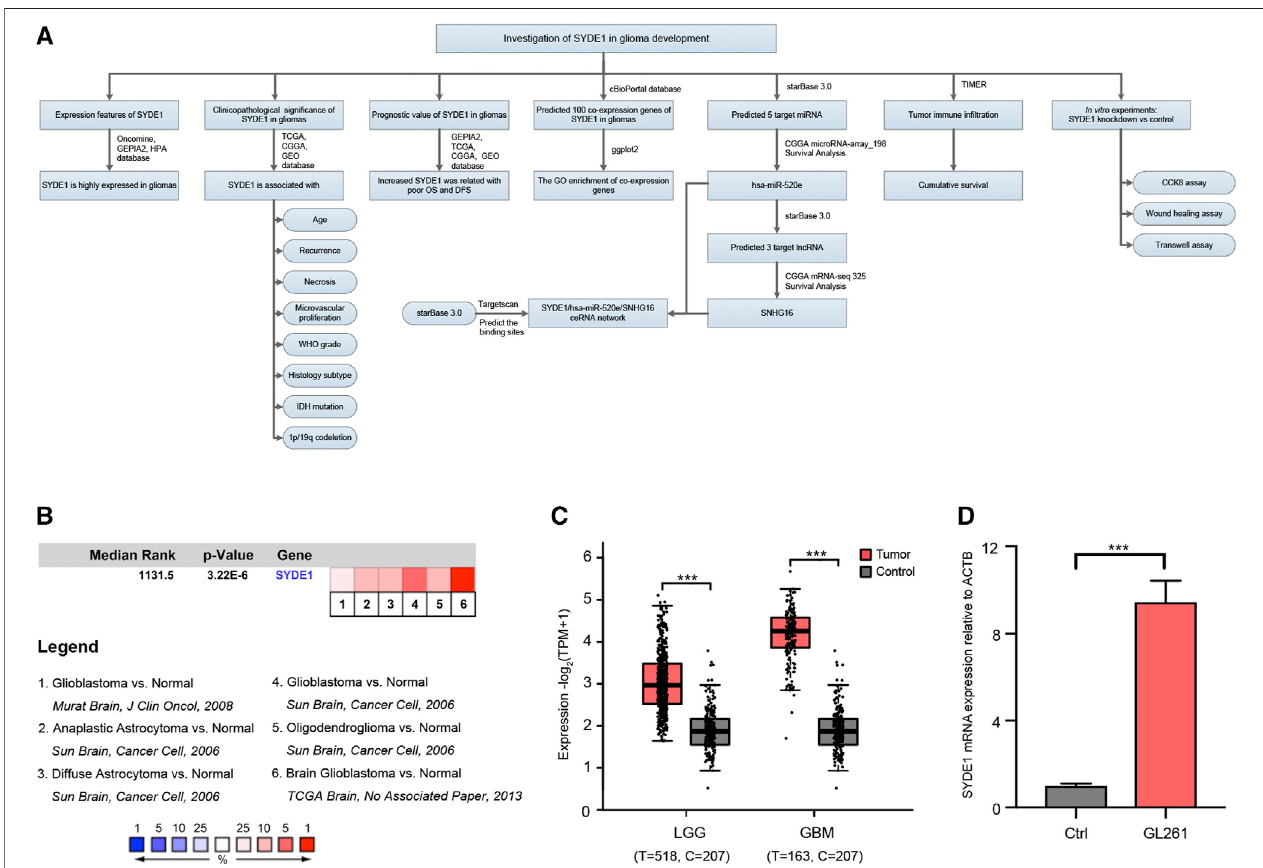
FIGURE 1 | The comparison of SYDE1 expression between normal brain and glioma tissues. (A) A schematic overview of different steps taken to examine the association between SYDE1 and glioma. (B) SYDE1 expression in normal human brains and different glioma subtypes. The rank for a gene is the median rank for that gene across each of the analysis and the p.value for a gene is its p.value for the median-ranked analysis. (C) SYDE1 expression in normal human brains, LGGs and GBMs. (D) SYDE1 expression in normal mouse brains and mouse glioma GL261 cells. ***, p.value < 0.001; Ctrl, normal C57BL6 mouse brain.